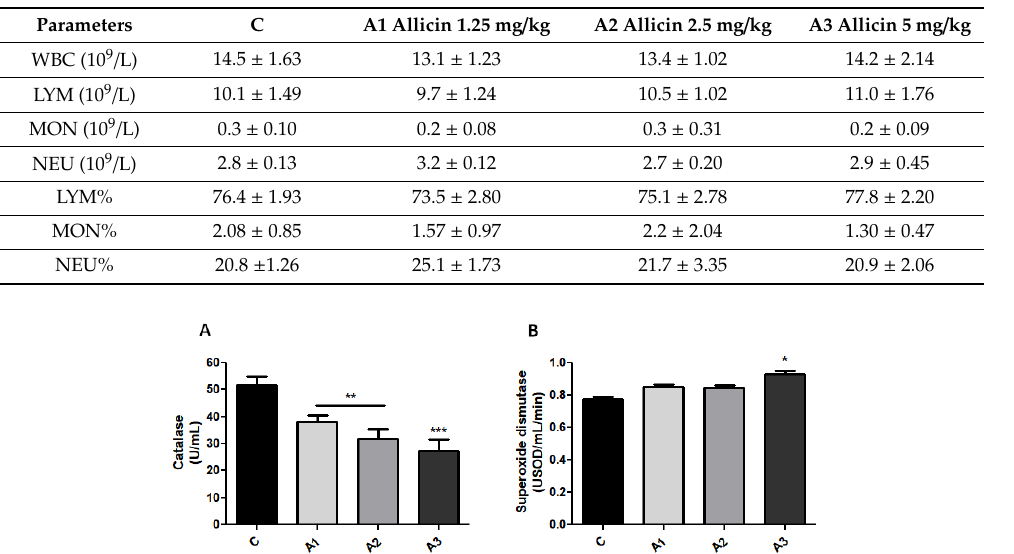
Figure 1. Serum catalase (CAT) and superoxide dismutase (SOD) activity in the control and experimental animals. ( A ) Allicin treatment decreased the catalase activity and ( B ) A3 slowly increased SOD activity. Values are expressed as mean ± SD (* p < 0.05; ** p < 0.01; *** p < 0.001).